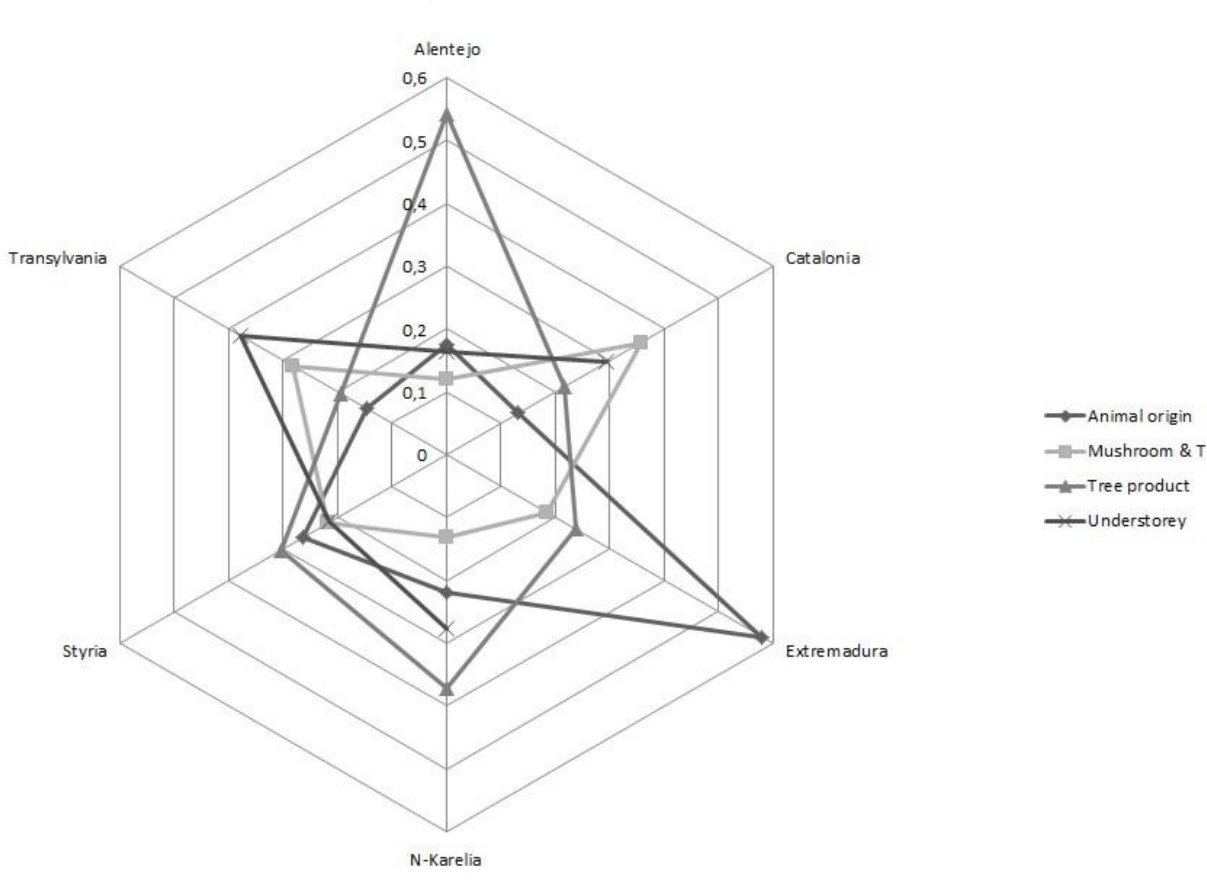
Figure 2. Cross-case study analysis of the overall performance (i.e., sum of global priorities) of the four NWFP categories under the “equal” weighting scenario.